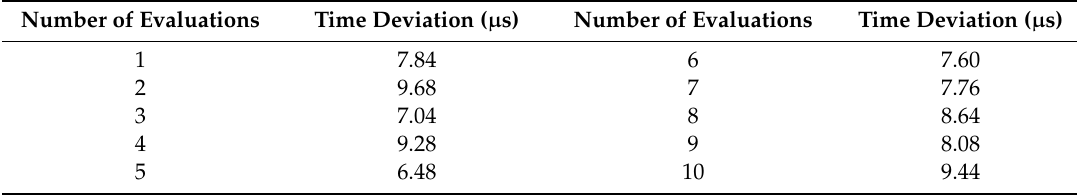
Table 1. Evaluation results of the synchronization in the CAN–Ethernet